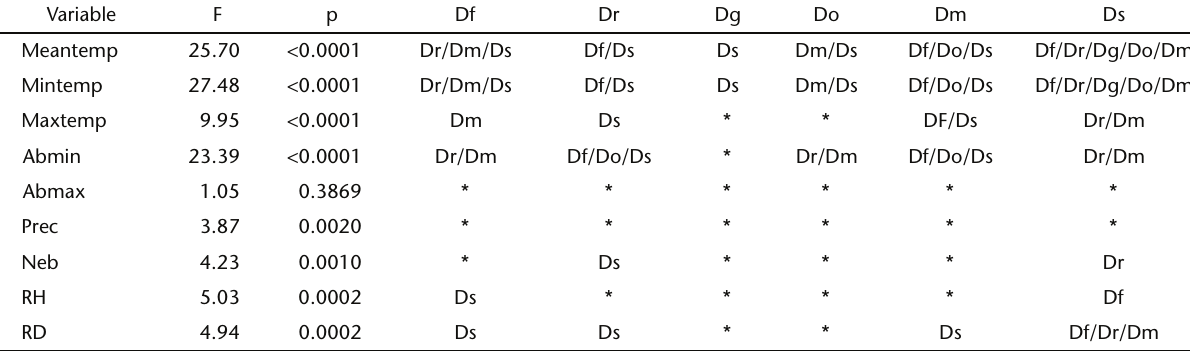
ZOOLOGIA 27 (1): 19–29, February, 2010